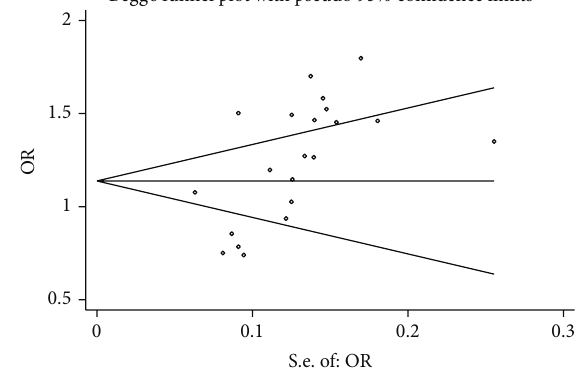
Figure 3: Begg’s funnel plot of the association between NFKB1 promoter − 94ins/del ATTG polymorphism and cancer risk (ins allele versus del